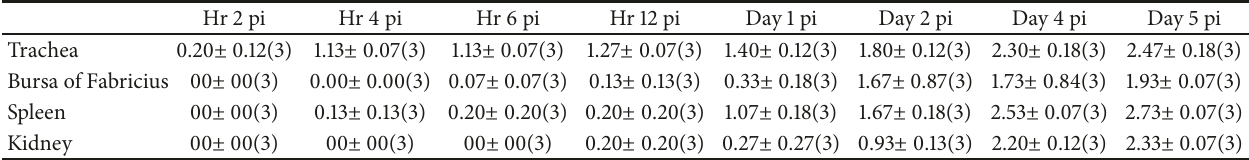
Table 6: Lesion scoring (0-5) induced by vNDV in HE stained tissues of the trachea, bursa of Fabricius, spleen, and kidney collected from hr 2 pi till day 5 pi.